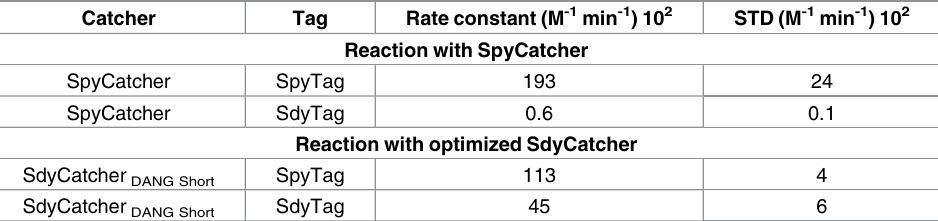
Table 2. Reaction rate constants between different ligation partners.